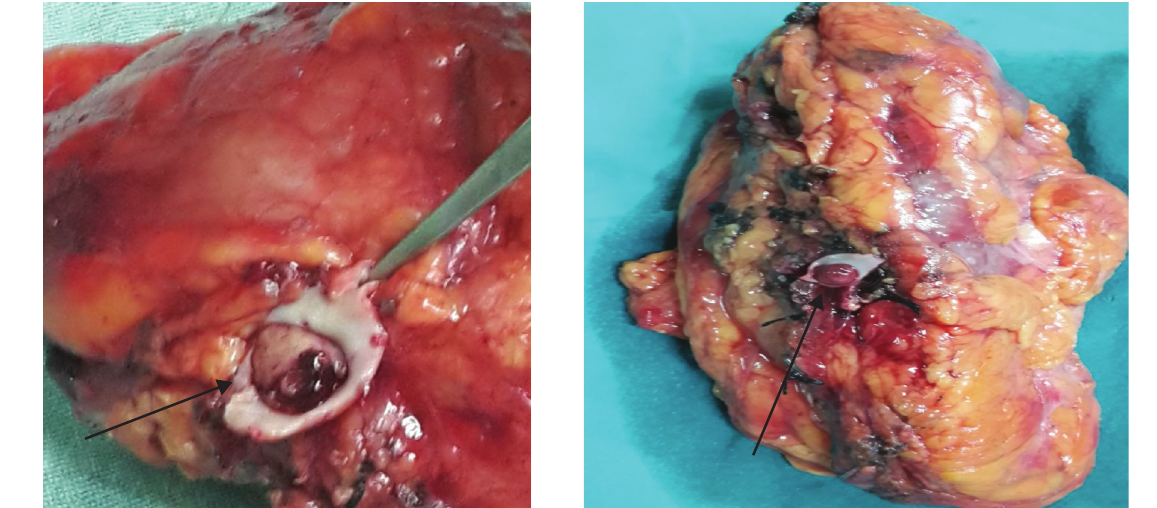
Figure 1: Level 1 thrombus (HPE Squamous cell carcinoma) with arrows showing level 1